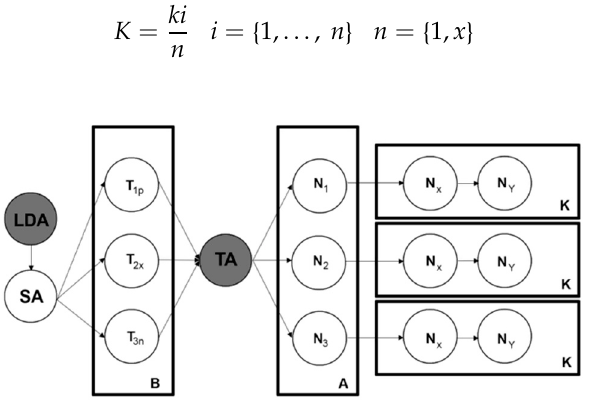
Figure 5. Textual analysis process after LDA sentiment identification. Source: Saura and Bennett [3].